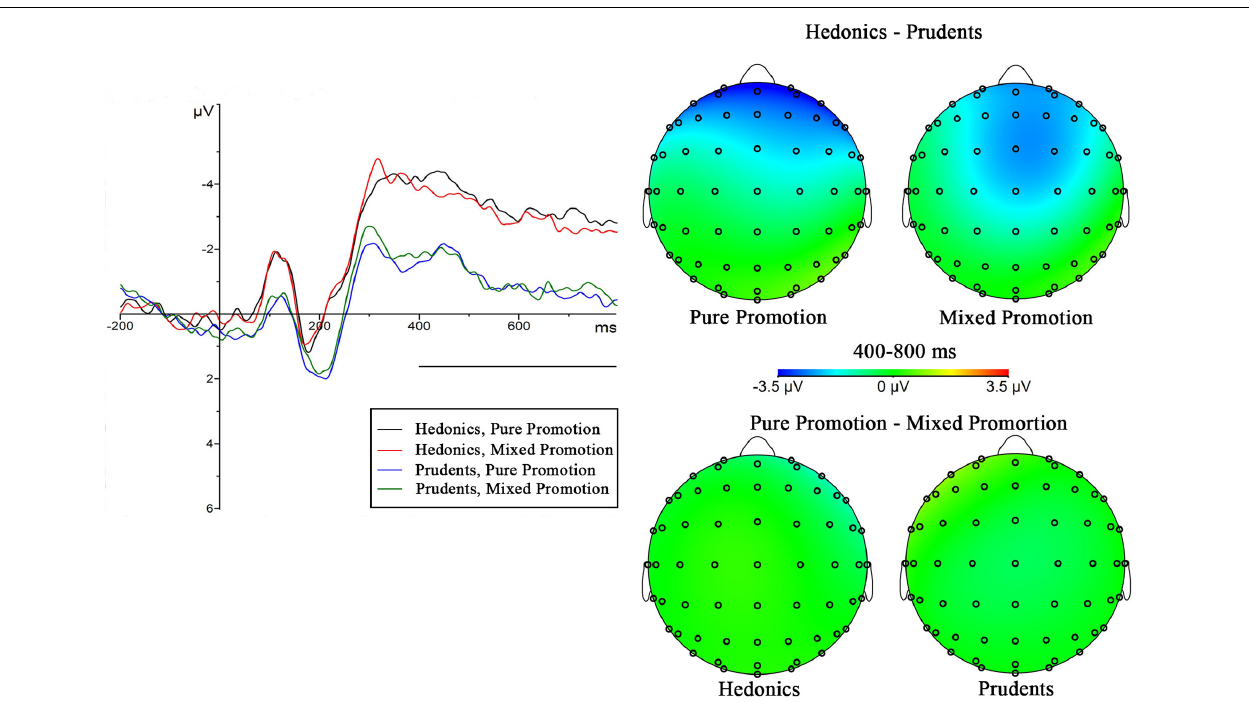
FIGURE 3 | The grand-averaged ERP waveforms (left) for every condition collected over electrodes F3, Fz, and F4. The difference maps (400–800 ms) were in the